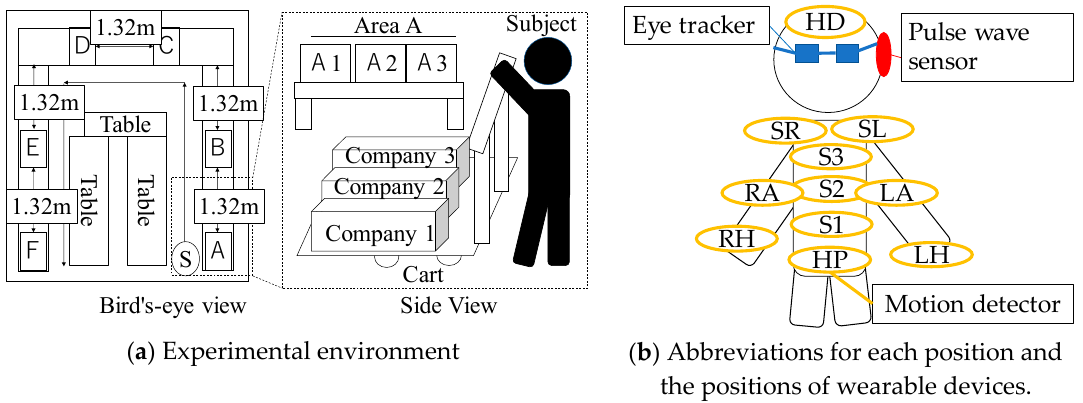
Figure 3. The experimental environment and the position of wearable devices.